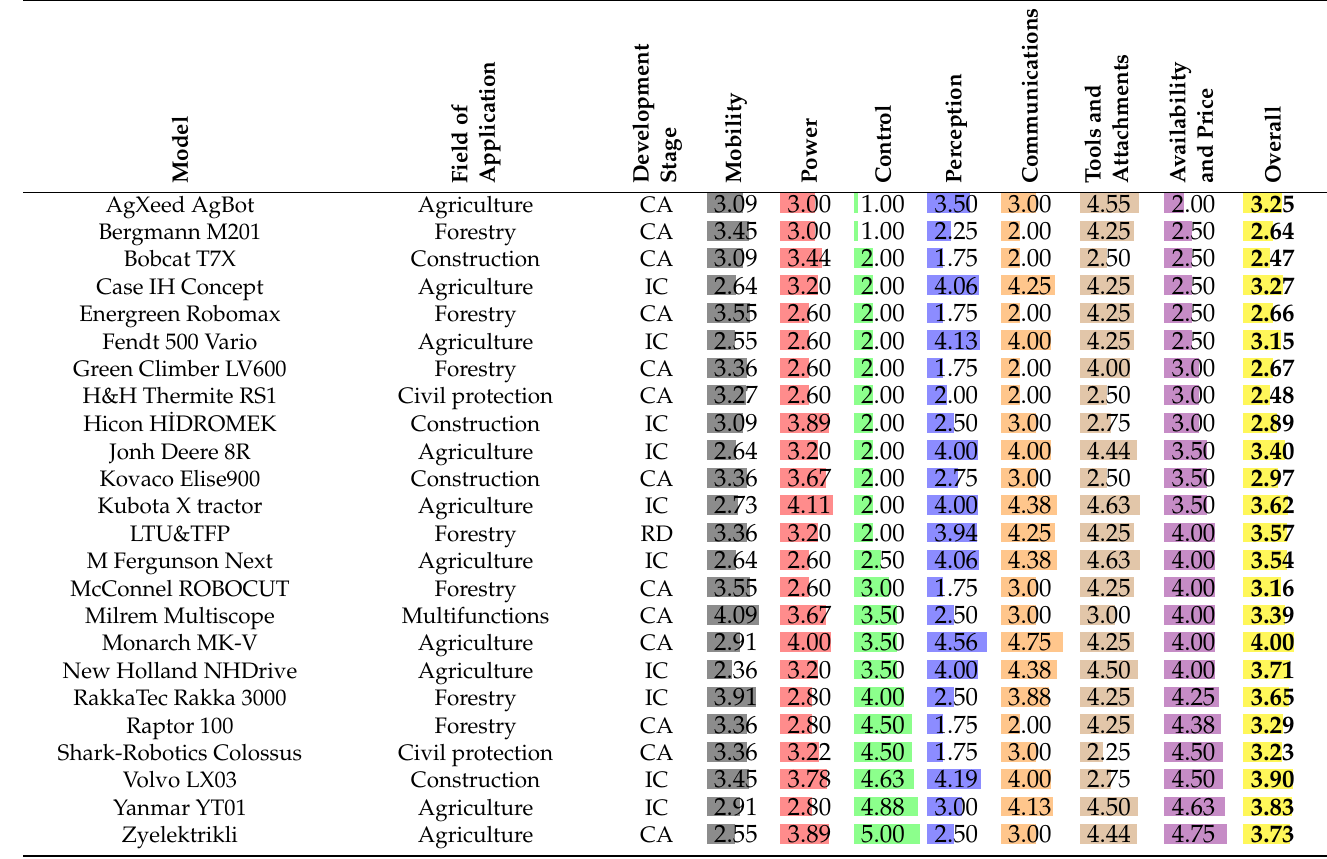
Table 1. Relevant MIMs chosen to serve as technological baseline, its original field of application, development stage and evaluation.